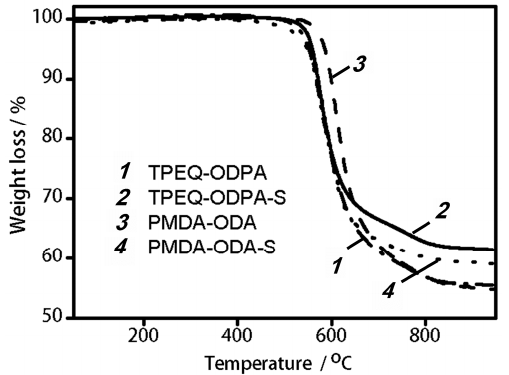
Figure 7. Thermogravimetric analysis (TGA) curves for the TPEQ-ODPA, TPEQ-ODPA-S, PMDA-ODA, and PMDA-ODA-S.